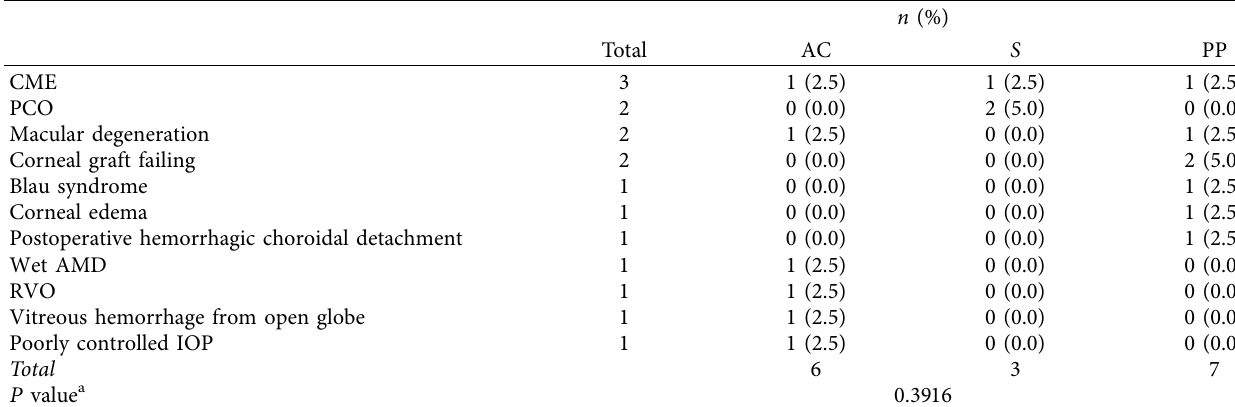
Table 9: Causes for > 1 line decrease in VA.